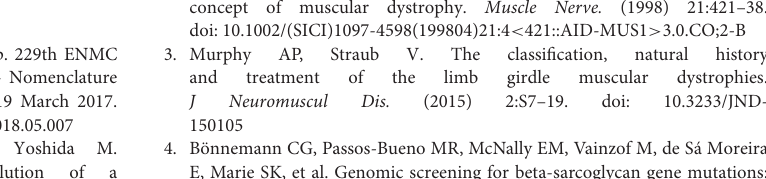
Supplementary Table 1 | Association between the rate in evolution of disease biomarkers and age at development of clinically relevant outcomes, disability, as evaluated by generalized linear models. CPK, Creatine Phosphokinase; EF, ejection fraction; VC, Vital Capacity, considered as percentage of predicted; FVC, Forced Vital Capacity, considered as percentage of predicted; FEV1, Forced Expiratory Volume in the first second considered as percentage of predicted. N = number of observations